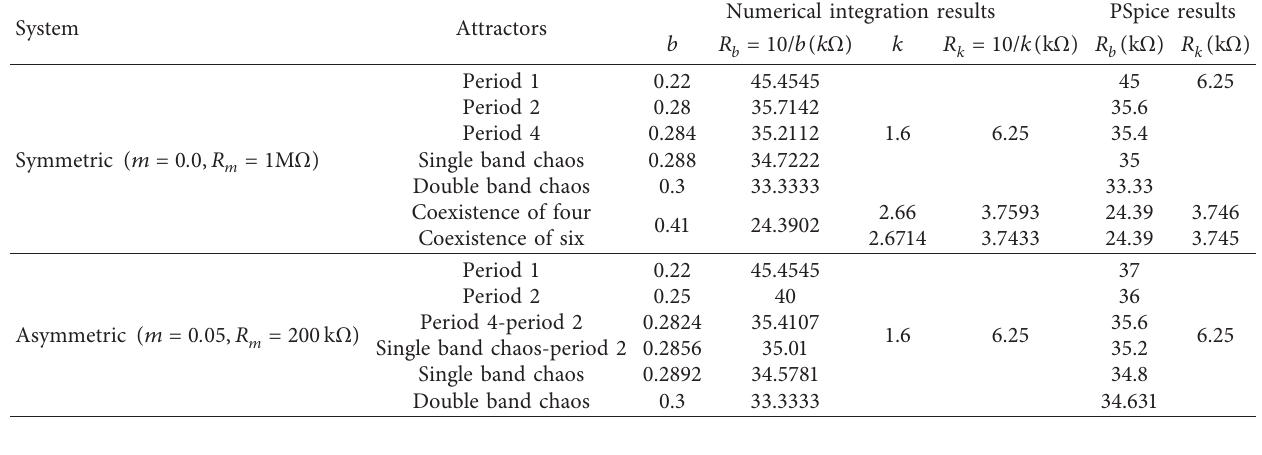
Table 3: Comparison between the results of numerical integrations and